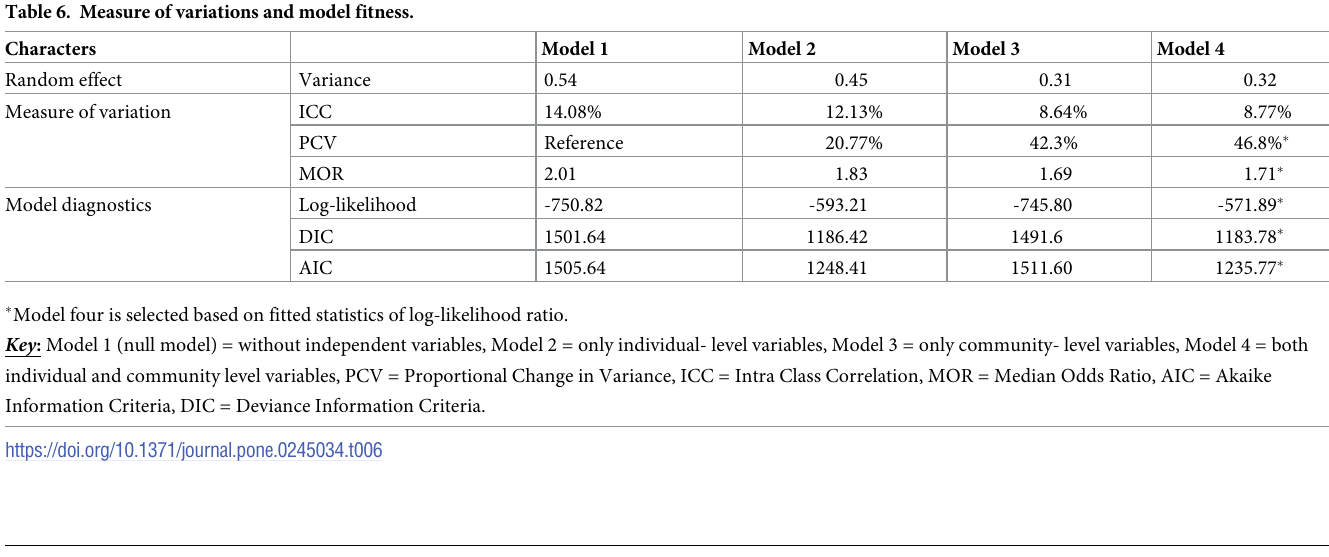
Table 6. Measure of variations and model fitness.